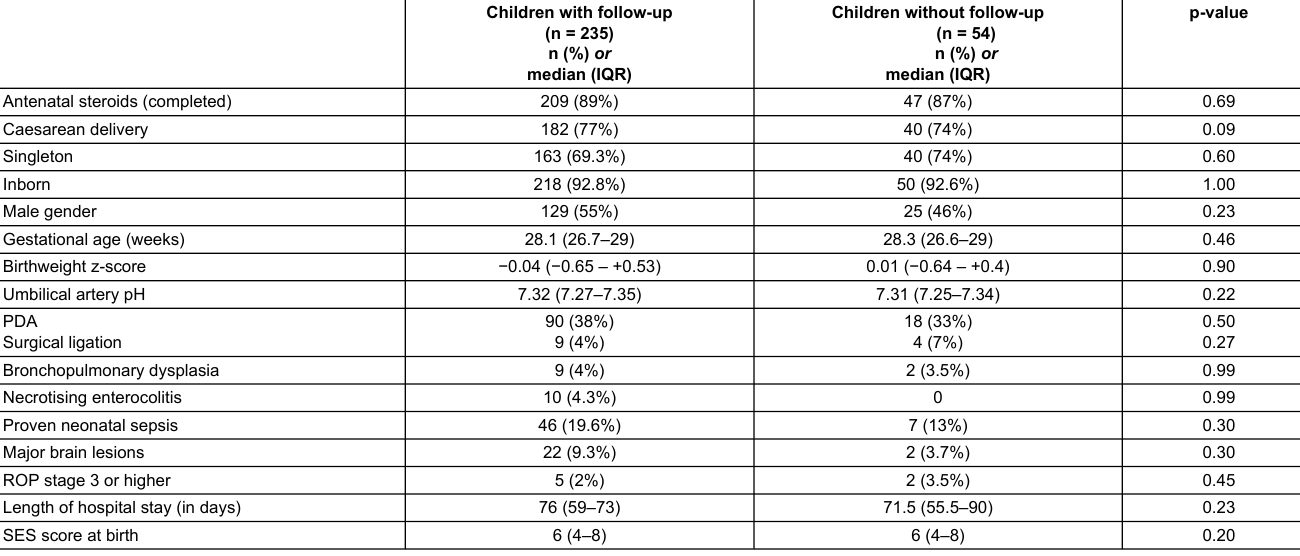
Table 1: Comparison of baseline and neonatal characteristics of children with and without a follow-up at early school age.